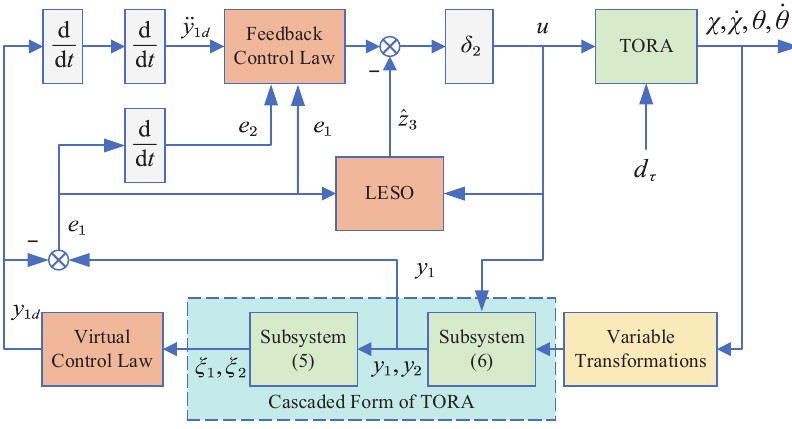
Figure 2. Block diagram of the closed-loop TORA control